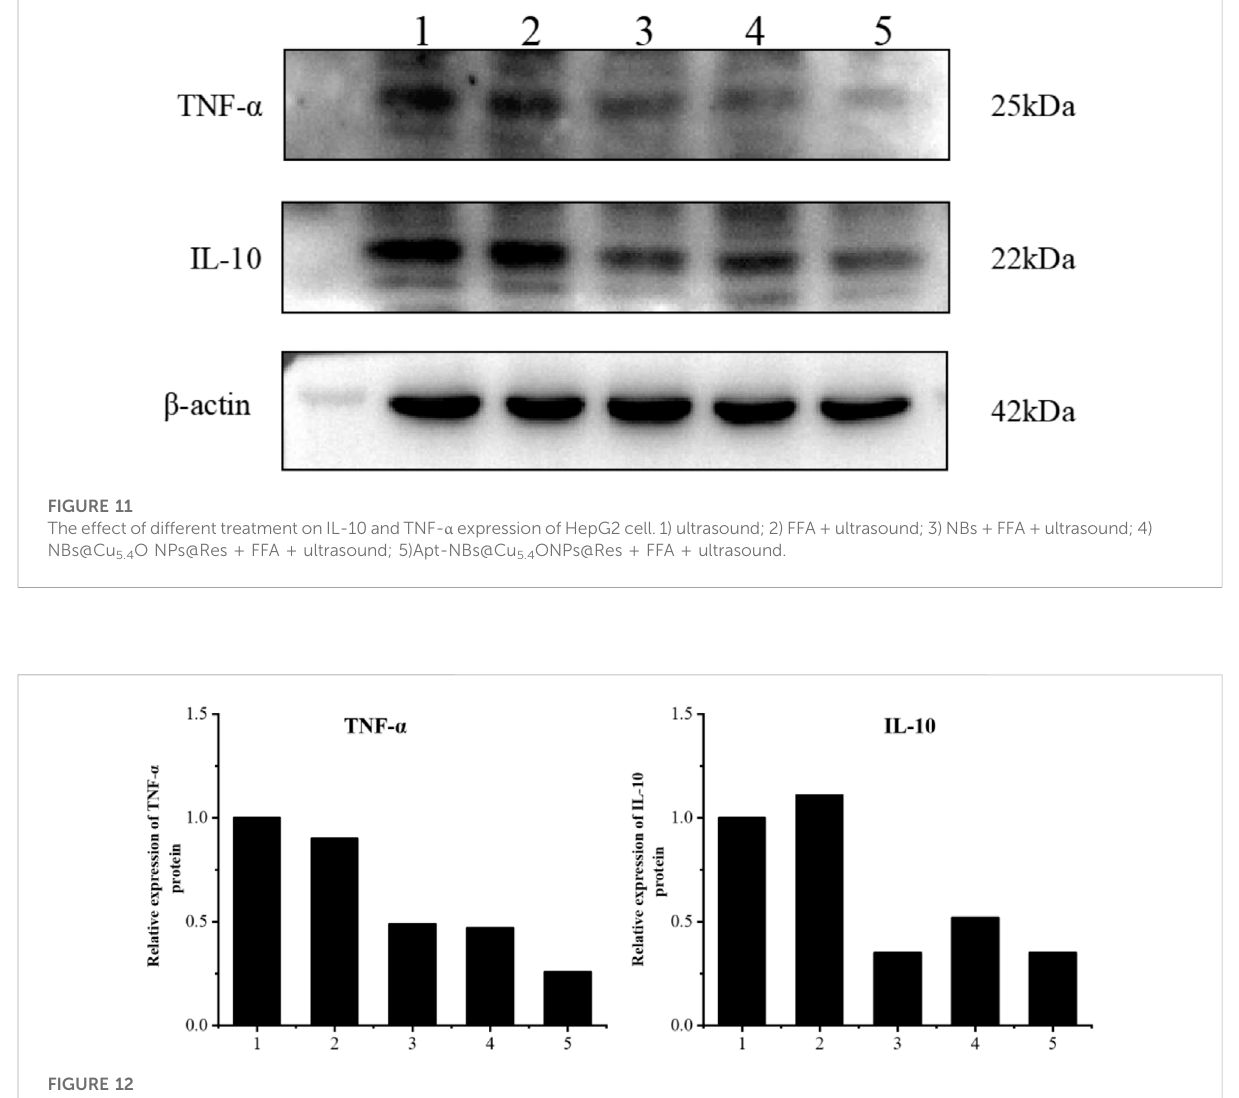
Relative levels ofTNF- α and IL-10 expressionafter indicated treatments. 1)ultrasound;2)FFA + ultrasound; 3) NBs+ FFA + ultrasound; 4) NBs@